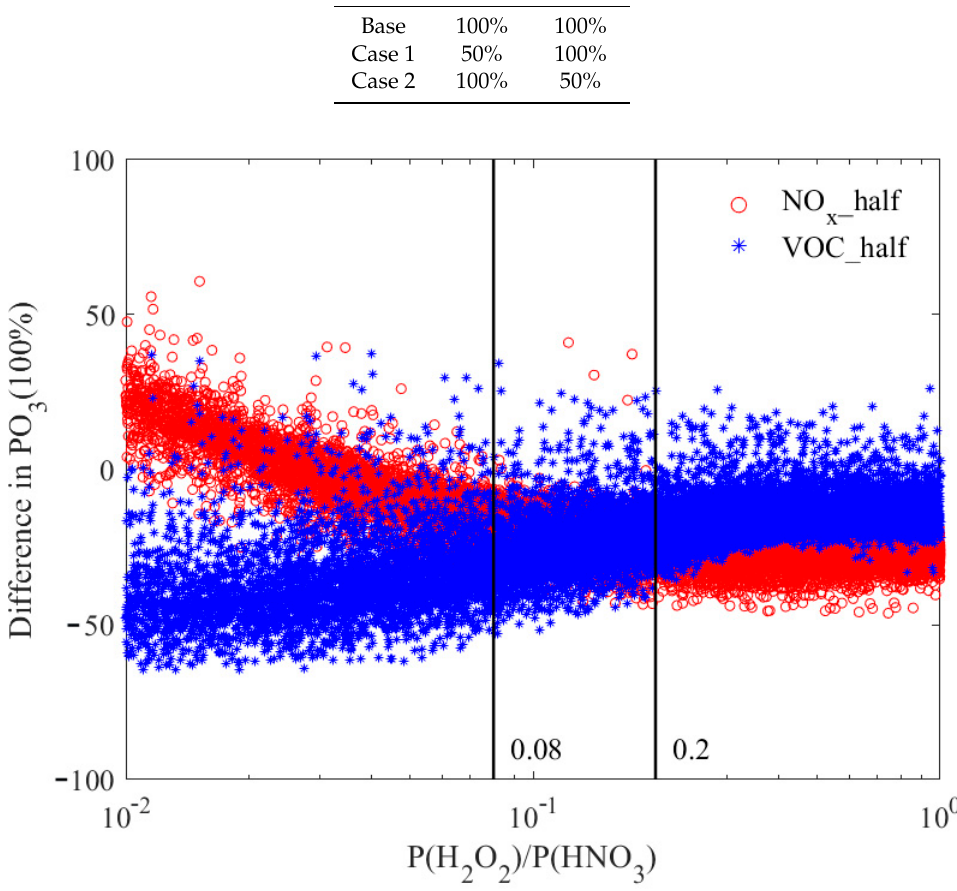
Figure 10. Scatter plot for the ratio of P(H 2 O 2 )/P(HNO 3 ) and the difference in P(O 3 ); blue indicates the sensitivity test with a 50% reduction in NOX emissions, and red indicates the sensitivity test with a 50% reduction in VOC emissions.